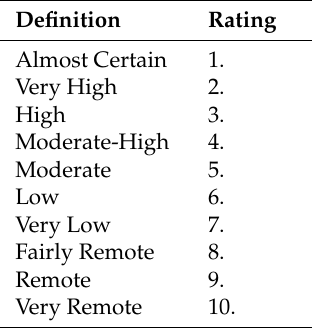
Table 3. Failure detection ranking (D).